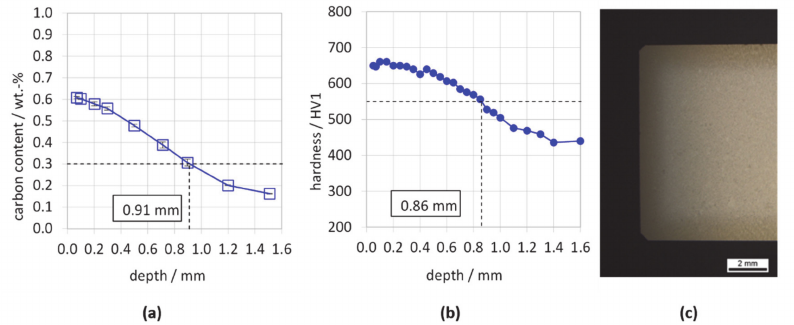
Figure 5. Carbon profile ( a ), microhardness profile ( b ), and micrograph of cross section ( c ) of a sample with target case hardening depth of 1 mm.